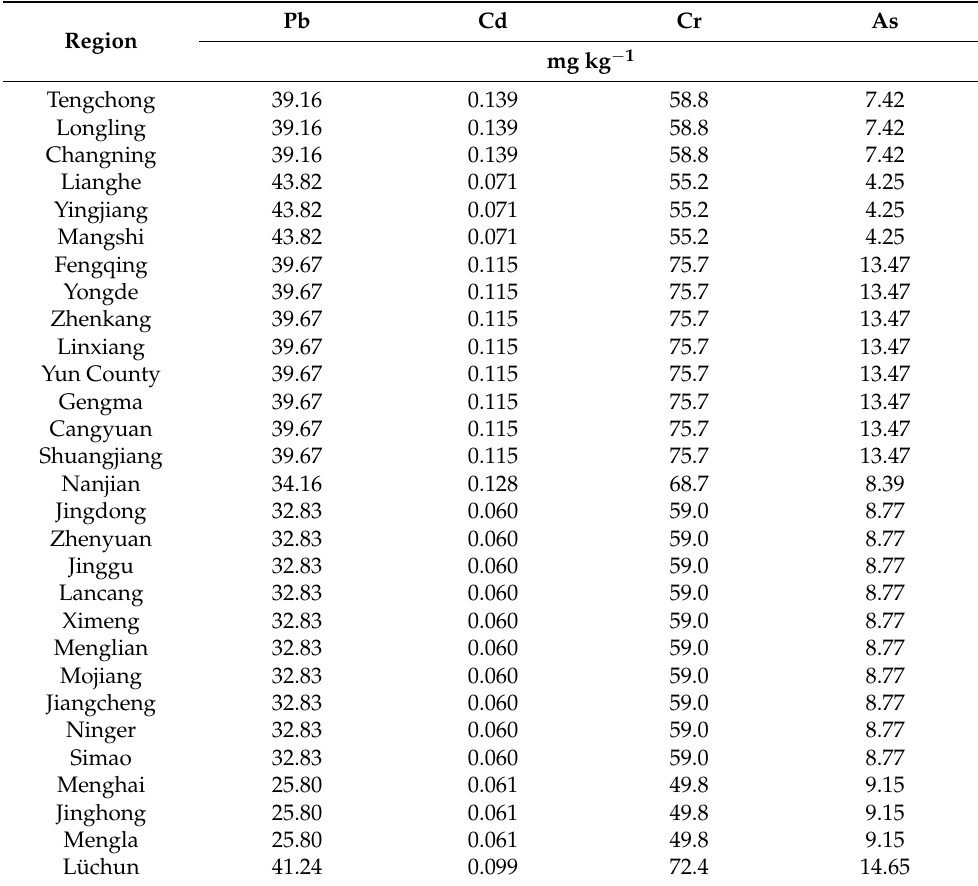
Table 1. Background values of lead (Pb), chromium (Cr), arsenic (As), and cadmium (Cd) in soils from selected